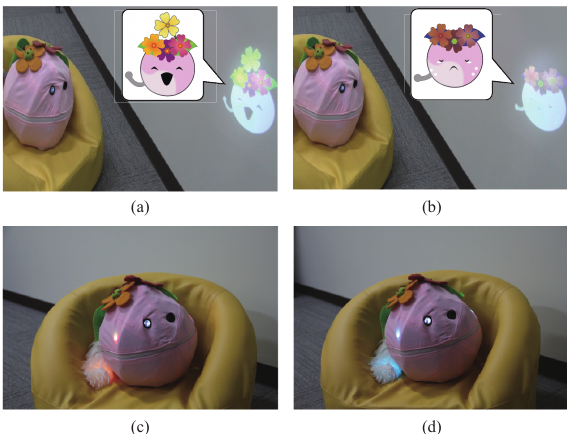
Figure 12. Representation of the robot’s affective expressions: ( a ) happy with Avatar; ( b ) sad with Avatar; ( c ) happy with LED; ( d ) sad with